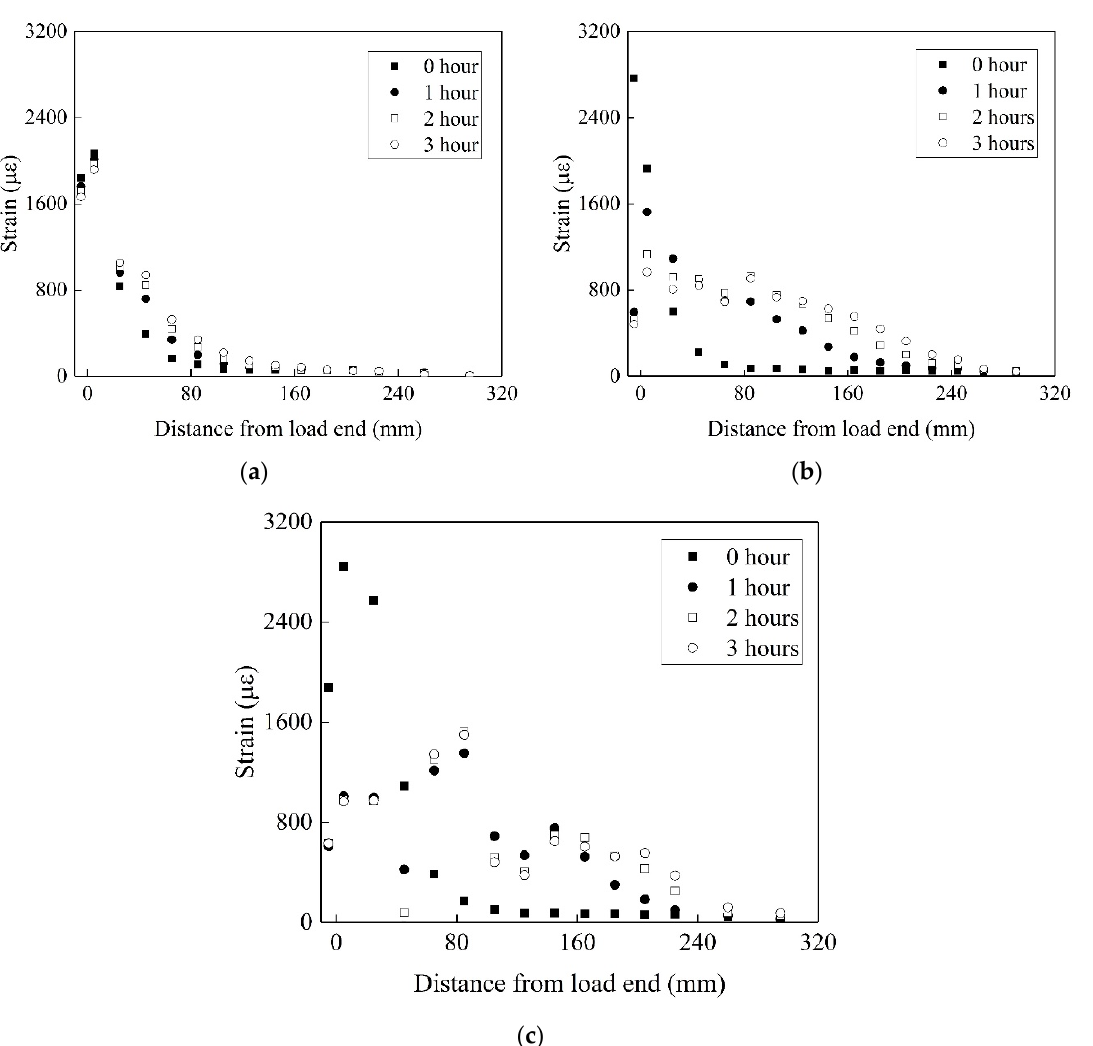
Figure 10. Strain vs. distance from load end: ( a ) 15 °C, ( b ) 40 °C, ( c ) 50 °C.